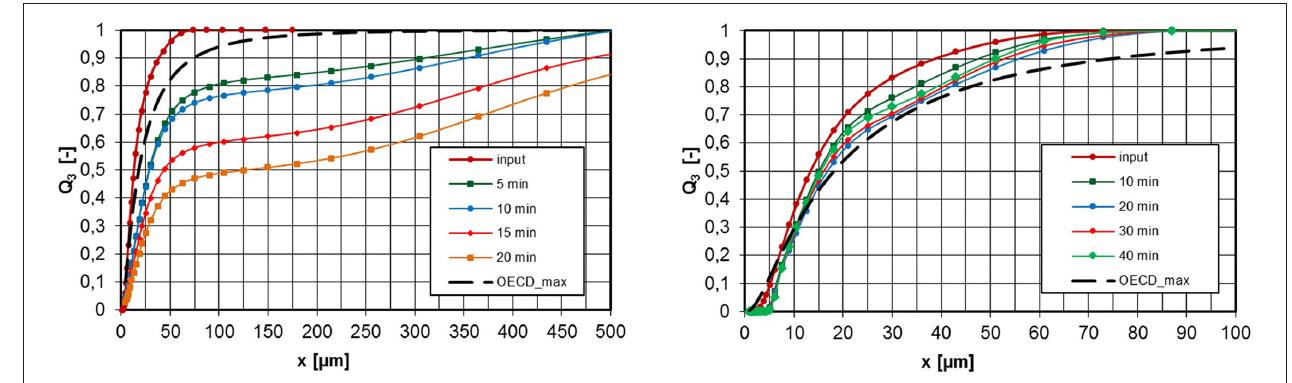
FIGURE 8 | PSD at the inlet and exhaust tube of the inhalation chamber for different operating times, untreated pyrogenic silica, ρ eff = 46,7 kg/m 3 (tamped density), left: c m = 4,700 mg/m 3 , right: 500 mg/m 3